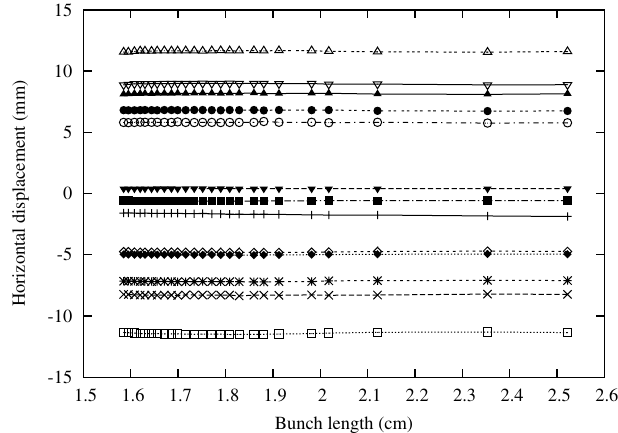
FIG. 3. Beam position at various detectors showing little or no bunch length dependence.